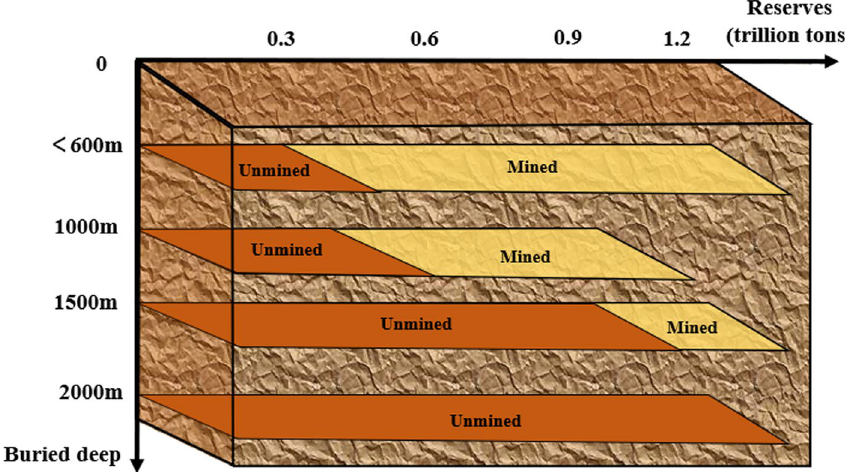
Fig. 3 Coal resource storage and mining situation at different